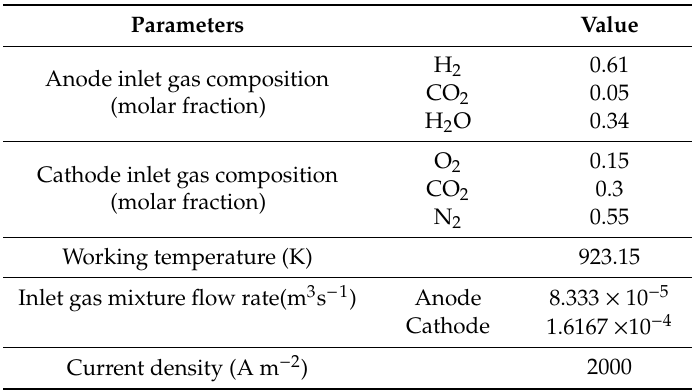
Table 3. The reference operating parameters of